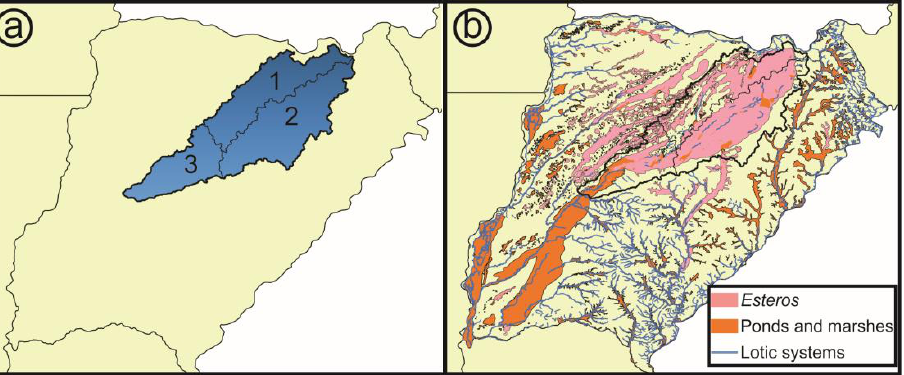
Figure 2. ( a ) Iberá Depression showing its sub-basins: 1: Carambolas , 2: Iberá , and 3: Naciente del Río Corriente , ( b ) Different types of wetlands within Corrientes